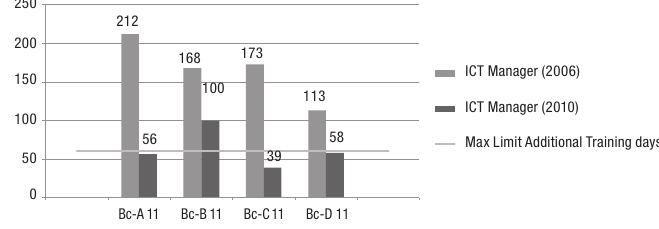
Fig. 4. Gap between the requirements of economic entities on knowledge and the knowledge offered by university graduates Source: